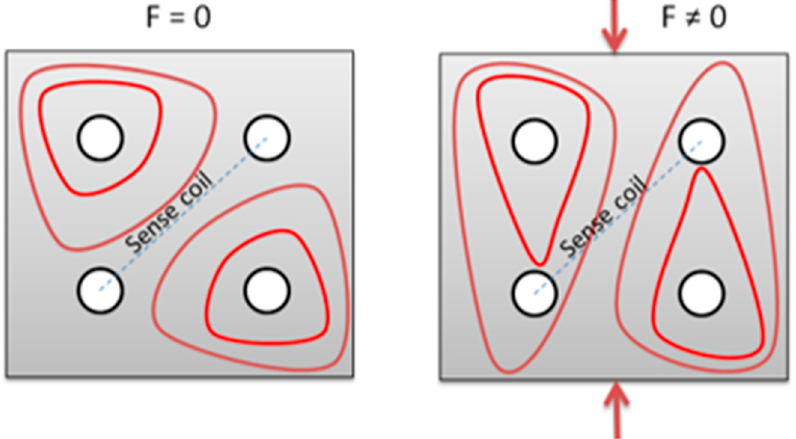
Figure 1. Distribution of magnetic field lines in the pressducer under the action of a non-zero compressive force [3,30].